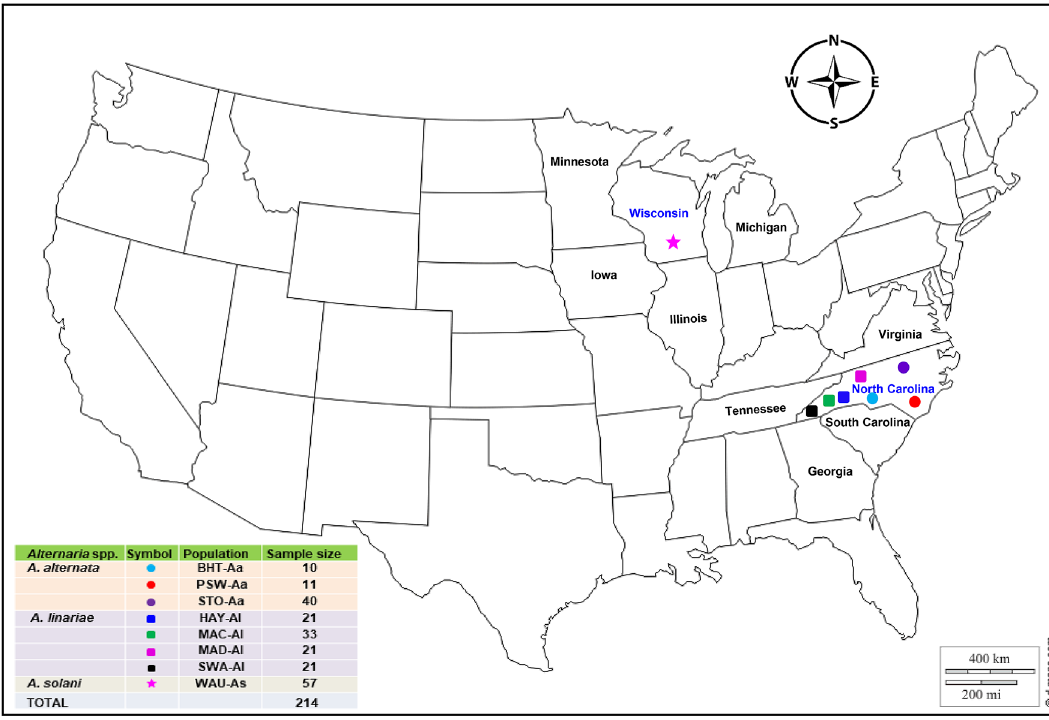
Figure 1. Map showing geographic locations in Wisconsin and North Carolina (https://d- maps. com), where Alternaria alternata , A. solani, and A. linariae were collected from potato and tomato and analysed in this study. The colour reflects the precise location from which isolates were collected. The number (sample size) of isolates collected from each location is